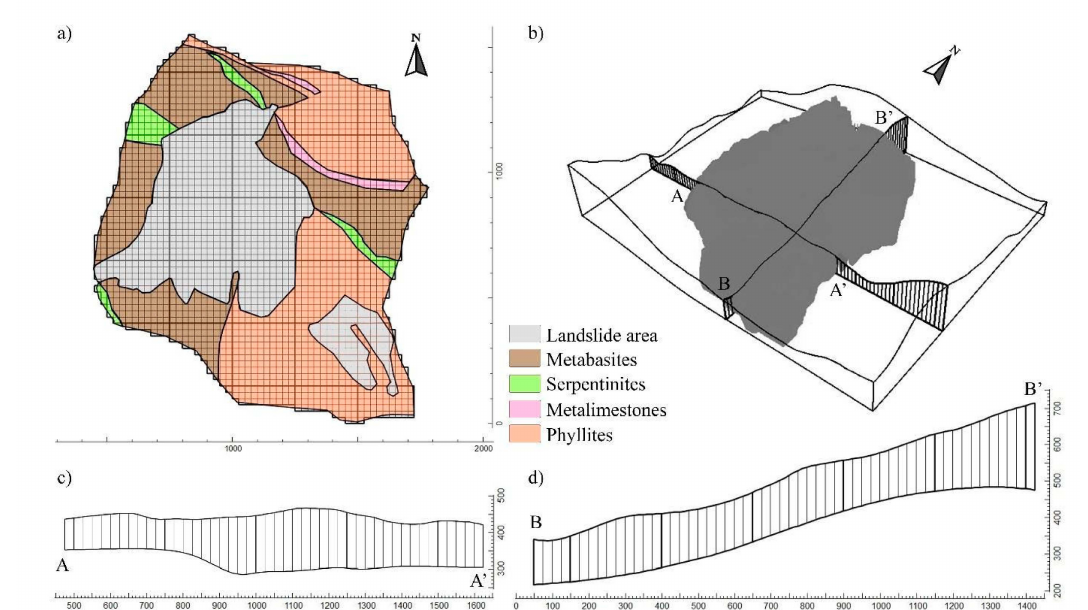
Figure 7. ( a ) Surface geological formations included into the model domain depicting zones with different hydrodynamic parameters; ( b ) 3D view of the model; ( c ) cross-section A-A’ and ( d ) cross- section B-B’ depicting the thickness layout of the